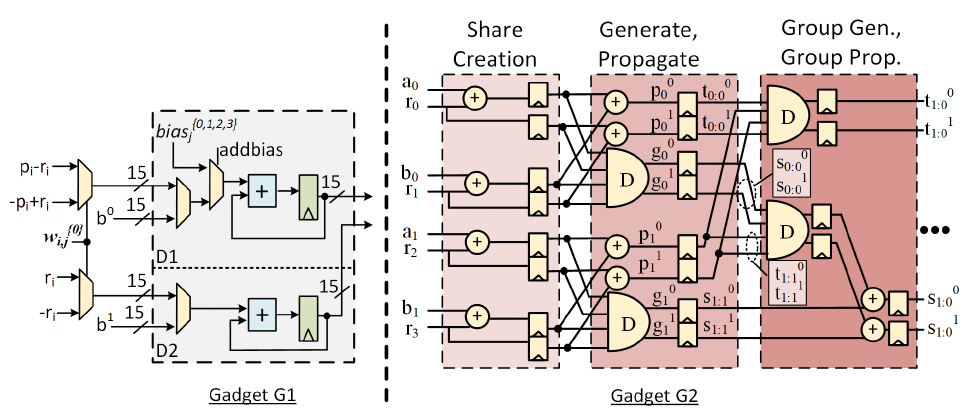
Figure 15: Circuit design of the masked gadgets G1 and a portion of G2 . Registers at the end of each sub block guarantee composability of the DOM